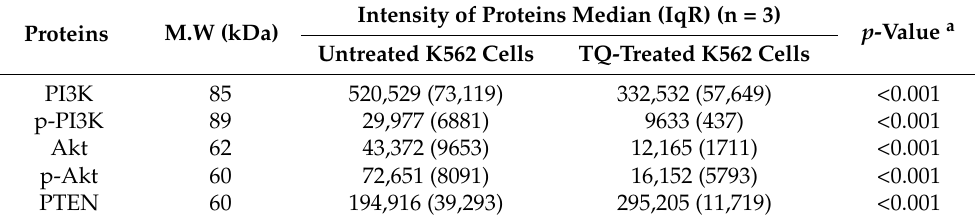
Table 2. Medians of protein intensity in K562